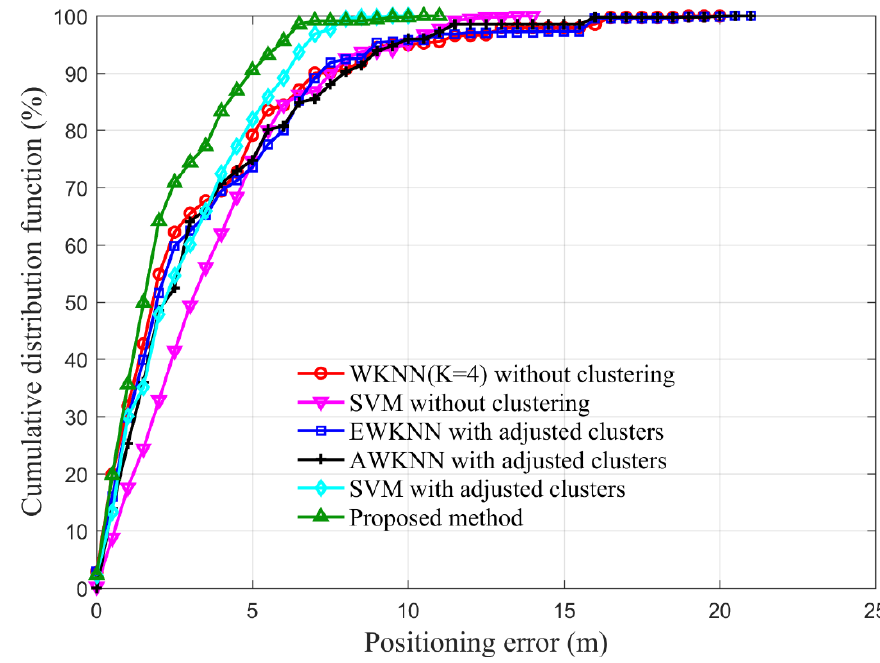
Figure 8. CDFs of positioning errors corresponding to six methods.